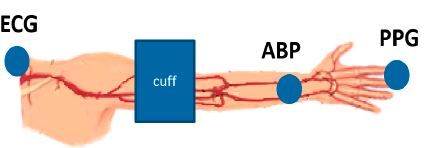
Figure 1. Sensor arrangement consisting of electrocardiogram ECG, blood pressure cuff, radial intra-arterial line ABP and photoplethysmogram PPG.